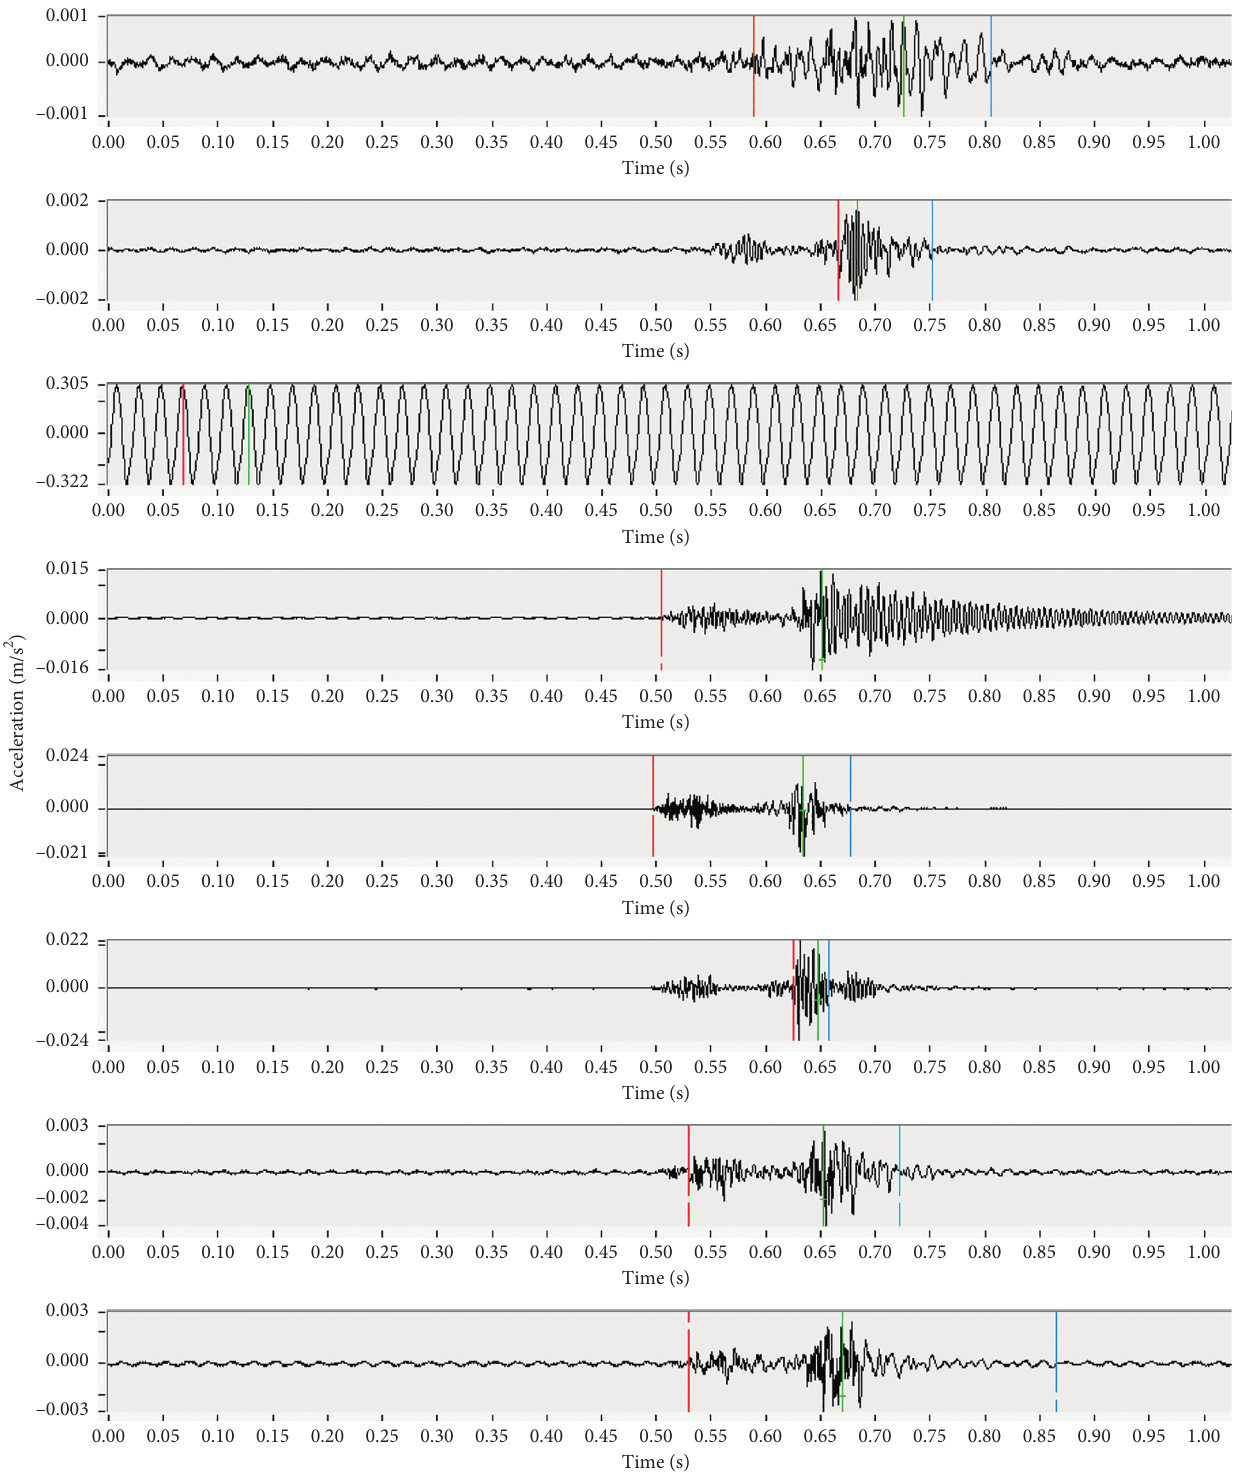
Figure 3: Error in determination of the signal’s first arrival